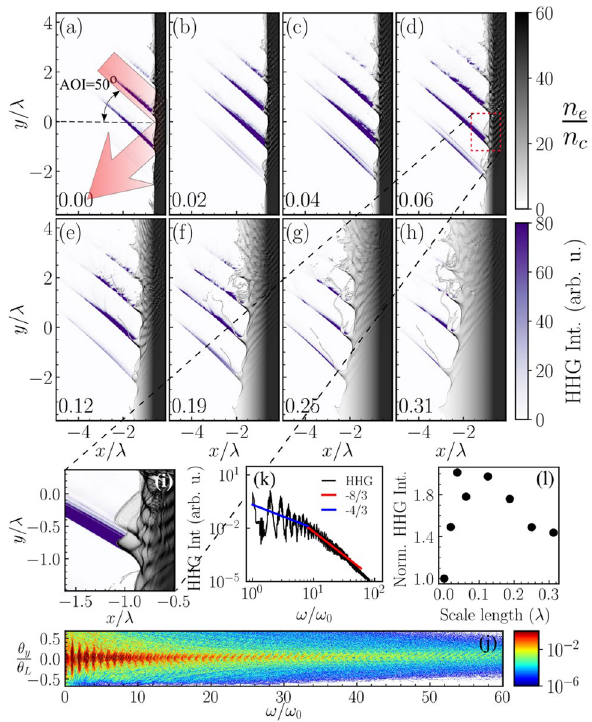
Figure 1. Electron density snapshots during high harmonic generation from a plasma target with plasma density scale-length (L) ( a ) L = 0 (cid:31) , ( b ) L = 0.02 (cid:31) , ( c ) L = 0.04 (cid:31) , ( d ) L = 0.06 (cid:31) , ( e ) L = 0.12 (cid:31) , ( f ) L = 0.19 (cid:31) , ( g ) L = 0.25 (cid:31) and ( h ) L = 0.31 (cid:31) . The numbers in the lower-left corners represent the plasma density scale- lengths ( L ) normalized to the fundamental pulse wavelength (cid:31) . The driving laser light is incident from the top left corner onto the target at 50° to the target normal, and the red shaded arrow in ( a ) indicates the direction of the incident and reflected beam propagation. Attosecond bursts in purple (with wavefront perpendicular to the reflected beam direction) are extracted by applying a Chebyshev type-I band-pass digital filter on the reflected field. ( i ) an enlarged view of the density snapshot shown in ( d ) for a better view of the plasma oscillation at the location of the high harmonic generation. ( j ) High harmonic spectrum generated in 2D-PIC simulation. The colormap represents the harmonic intensity in arbitrary units. The y-axis represents the harmonic emission angle θ y normalized with laser divergence angle θ L . ( k ) High harmonic spectrum in log-log scale. The harmonic intensity is normalized to the intensity of the fundamental frequency laser, showing two distinct slopes. Harmonic order 8–60th follows a slope of − 8/3 indicative of harmonics generated via the ROM mechanism. ( l ) Total yield of harmonics 8–60th as a function of the plasma density scale-length ( L ), normalized with respect to the yield at L = 0